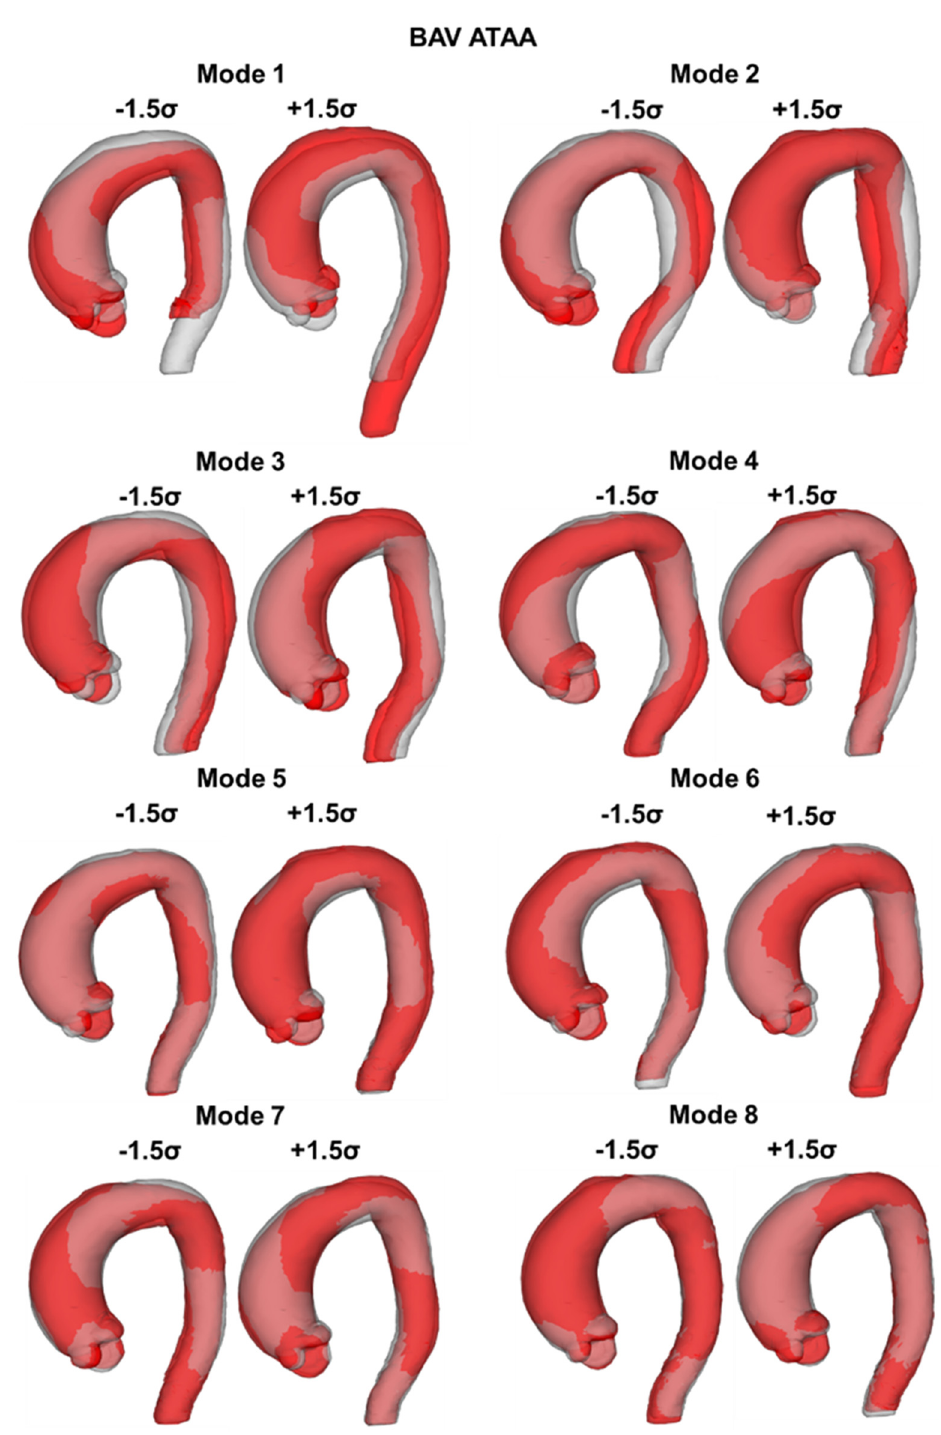
Figure 4. Dominant shape modes shown by deforming the mean BAV ATAA template (grey color) from low ( − 1.5 σ ) to high (+1.5 σ ) shape boundaries (red color).